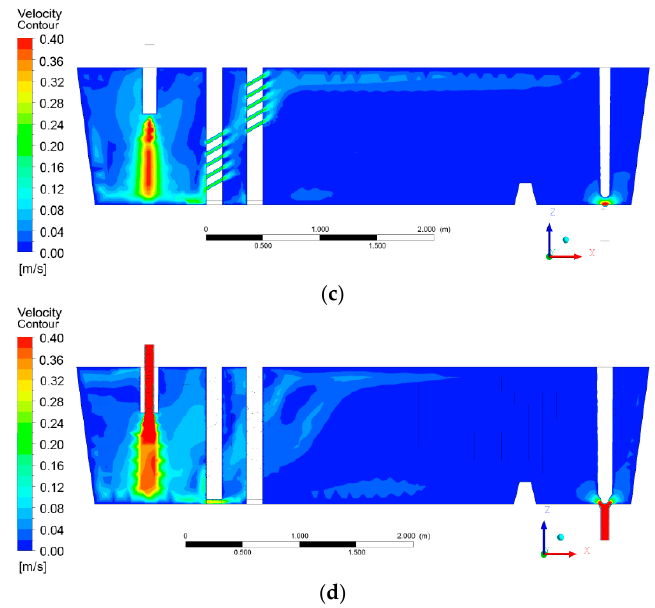
Figure 5. Contour graphs of the flow field in tundish with different control flow devices. ( a ) UAIB; ( b ) UILO mode; ( c ) LIUO mode; ( d ) X mode.